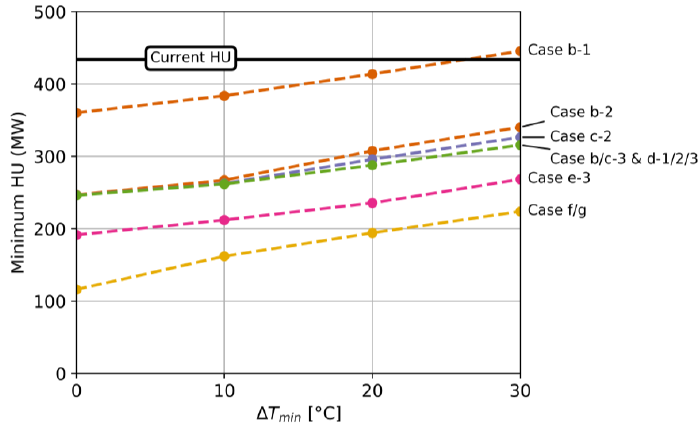
Figure 10. Hot utility targets for the cases where a steam network is used to exchange heat indirectly in addition to different degrees of direct heat integration.